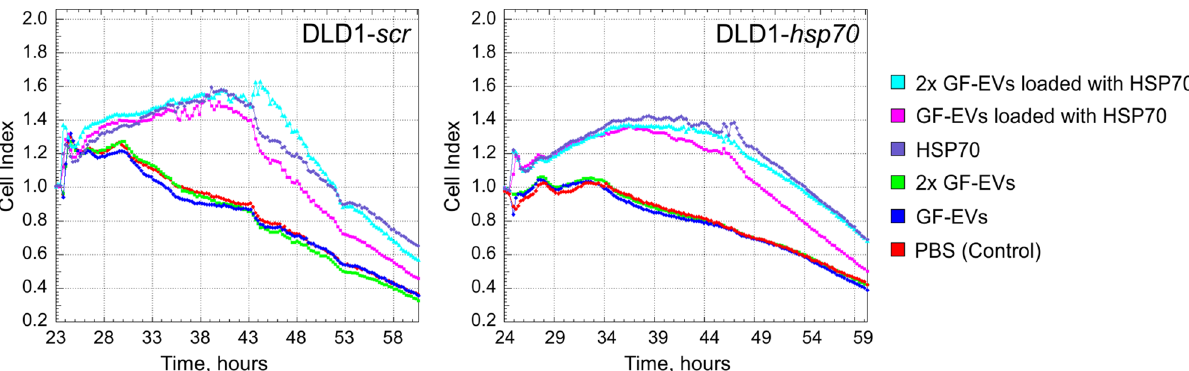
Figure 6. Protective effect of GF-EVs loaded with HSP70 from the etoposide-induced cytotoxicity. DLD1- scr (left) or DLD1- hsp70 (right) cells were preincubated in E-plates for 19–20 h before the addition of HSP70 at concentration of 2 μg/mL or GF-EVs loaded with HSP70 (10 6 or 2 × 10 6 particles per cell, appr. 1 μg/mL or 2 μg/ mL of HSP70 respectively); 4 h later the etoposide (EP) was added to a final concentration of 20 μM in each well. Recording with the aid of xCELLigence equipment was started immediately after drug added and lasted for 60 h. In every experiment, each point in the plot represents an average recording of two wells. In each panel, data from one of two independent experiments are